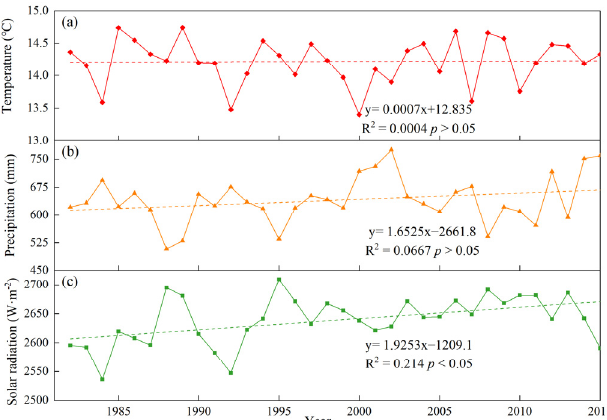
Figure 2. ( a ) Annual average temperature, ( b ) annual average precipitation, and ( c ) annual average solar radiation in Argentina from 1982 to 2015.